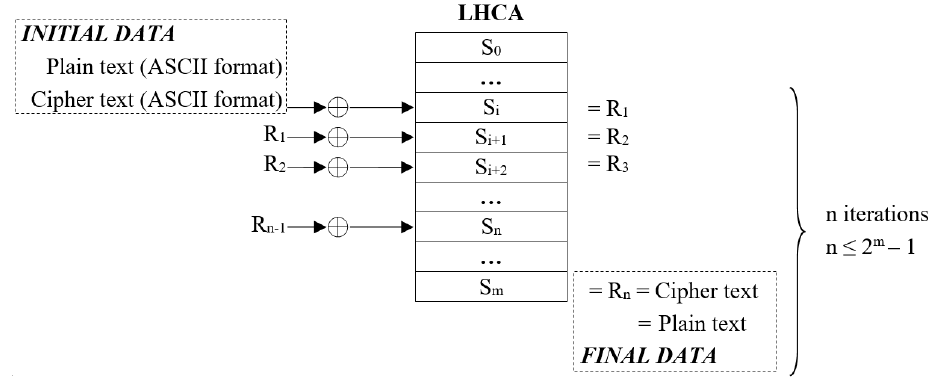
Figure 3. General encryption/decryption process.